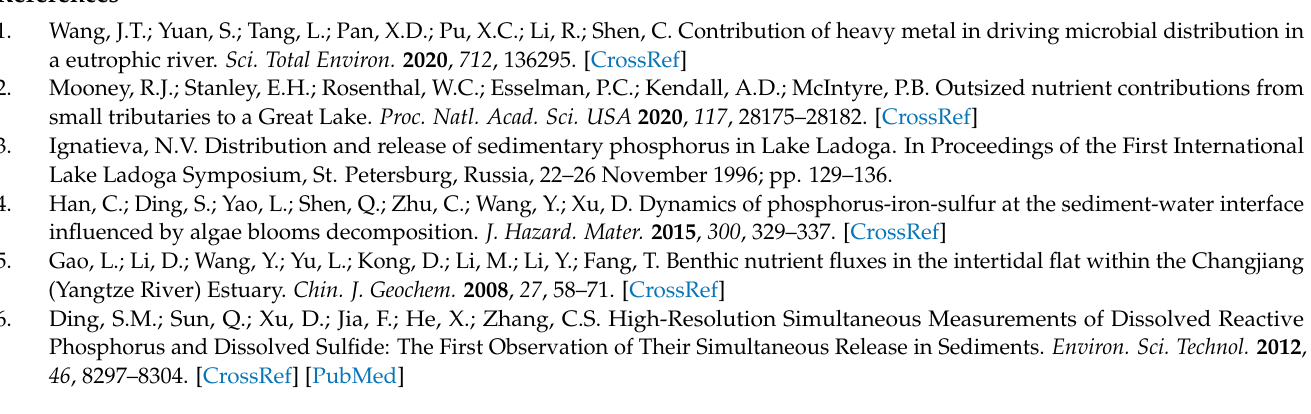
bacterial function; Figure S4: TOC concentration of sampling sites sediment; Table S1: The longitudes and latitudes of the sampling